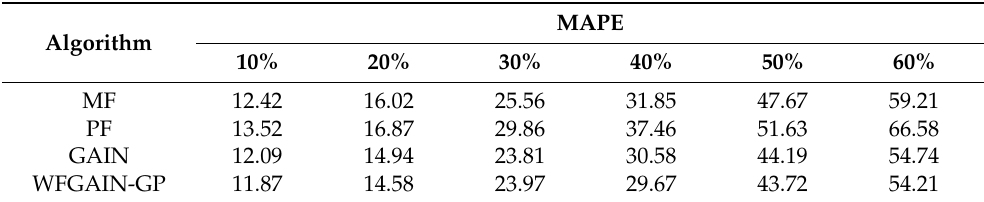
Table 7. MAPE values of the imputation results for various models under different missing rates. Mean Absolute Percentage Error (MAPE) is used to measure the difference between predicted and actual values and to express it as a percentage, making it suitable for comparing the prediction accuracy of datasets with different units.